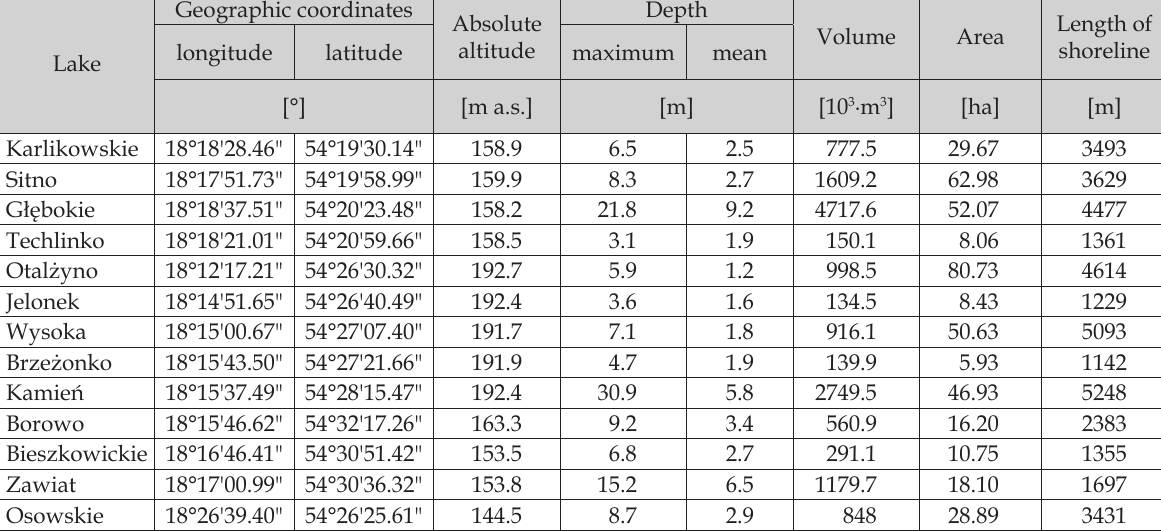
Table 2. Chosen morphometric parameters